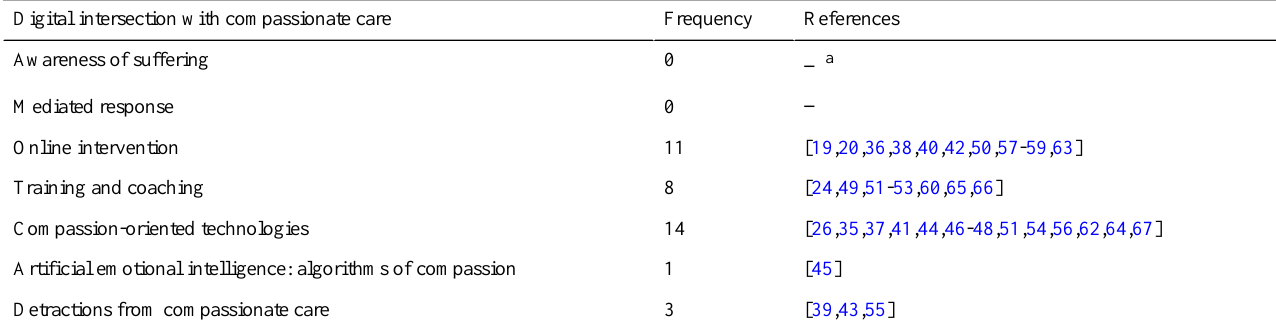
Table 4. Digital intersections with compassionate